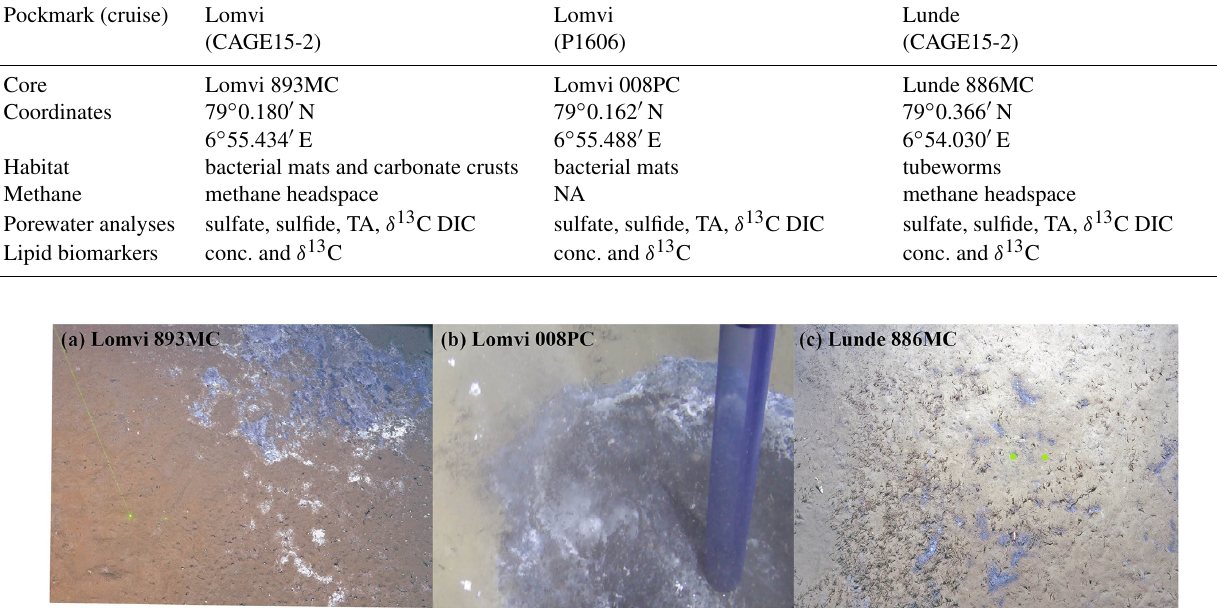
Table 1. Information on coring stations, coring coordinates, seafloor habitat information, and analyses performed at each site. DIC: dissolved inorganic carbon; TA: total alkalinity; conc.: concentration; NA – not available.